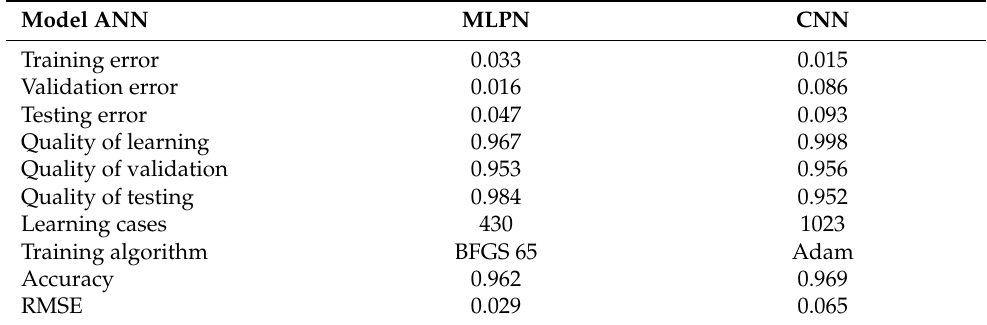
Table 2. The results of training